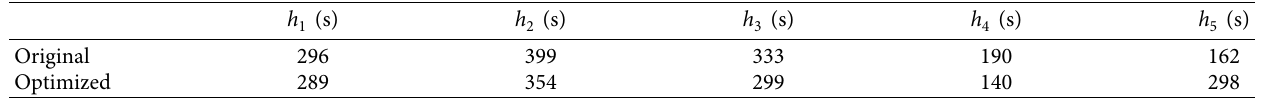
Figure 10: Convergence curve of PTT. Table 6: Original and optimized headways.